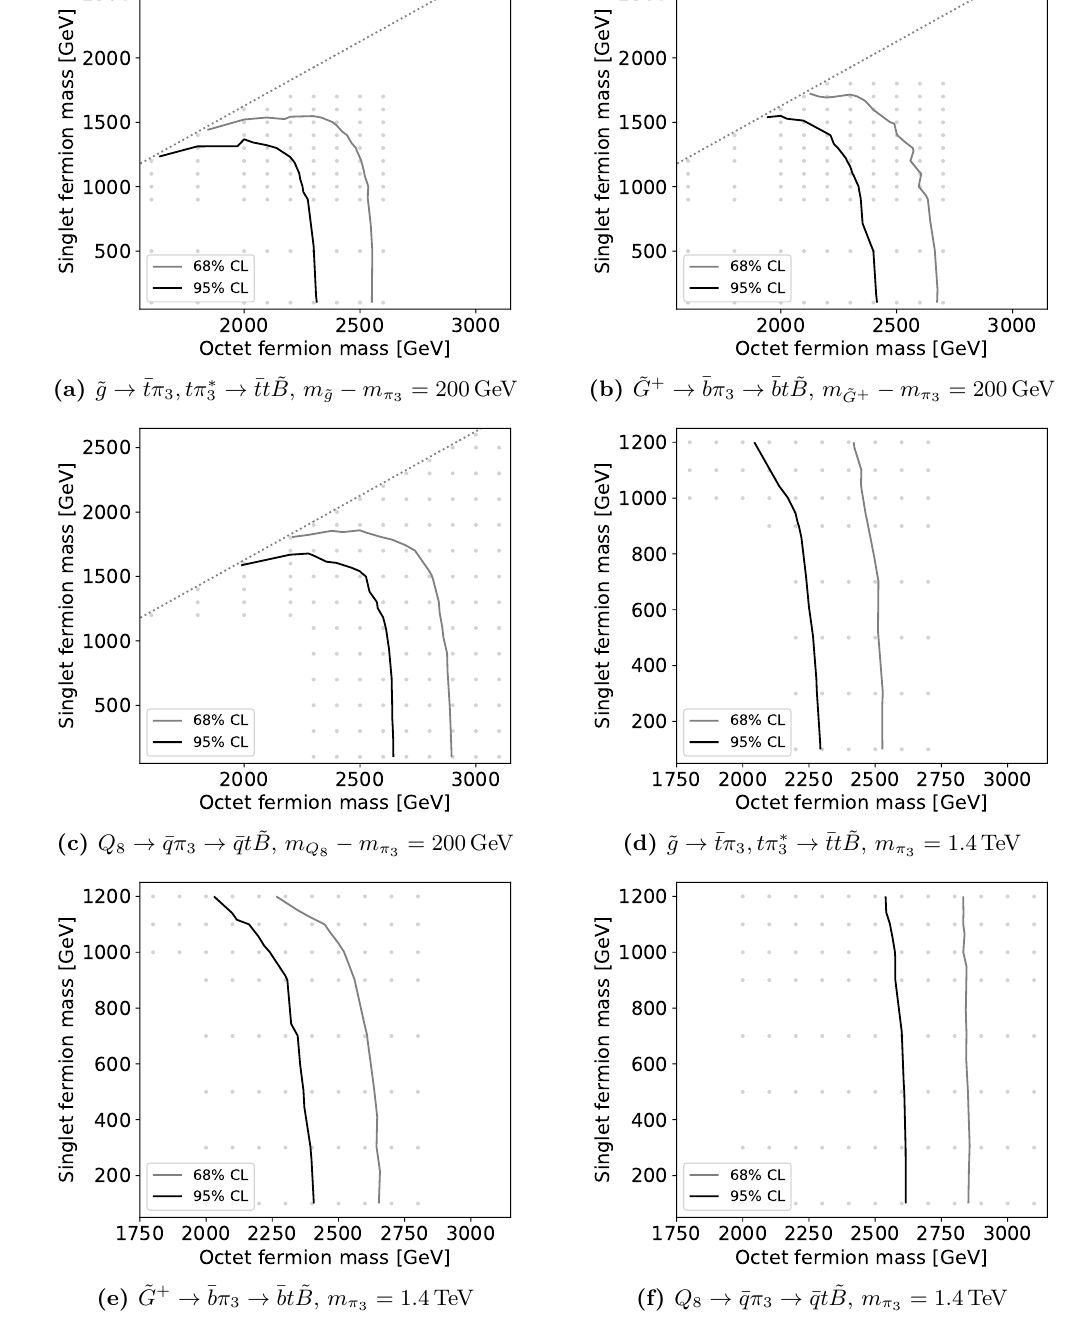
Figure 5. Bounds on the fermion masses for QCD pair production of an octet fermion Q 8 with subsequent decay to a SM third generation quark t/b and π . The first row shows the case of a 3 constant difference between the octet mass and the π mass of 200 GeV below the octet mass. In the 3 second row we have fixed m = 1 . 4 TeV. We include only the ˜ g in the first and ˜ G + in the second π 3 column. The third column shows the bounds for the full octet multiplet Q = (˜ g, ˜ G + , ˜ G 0 ) , assuming 8 it is mass